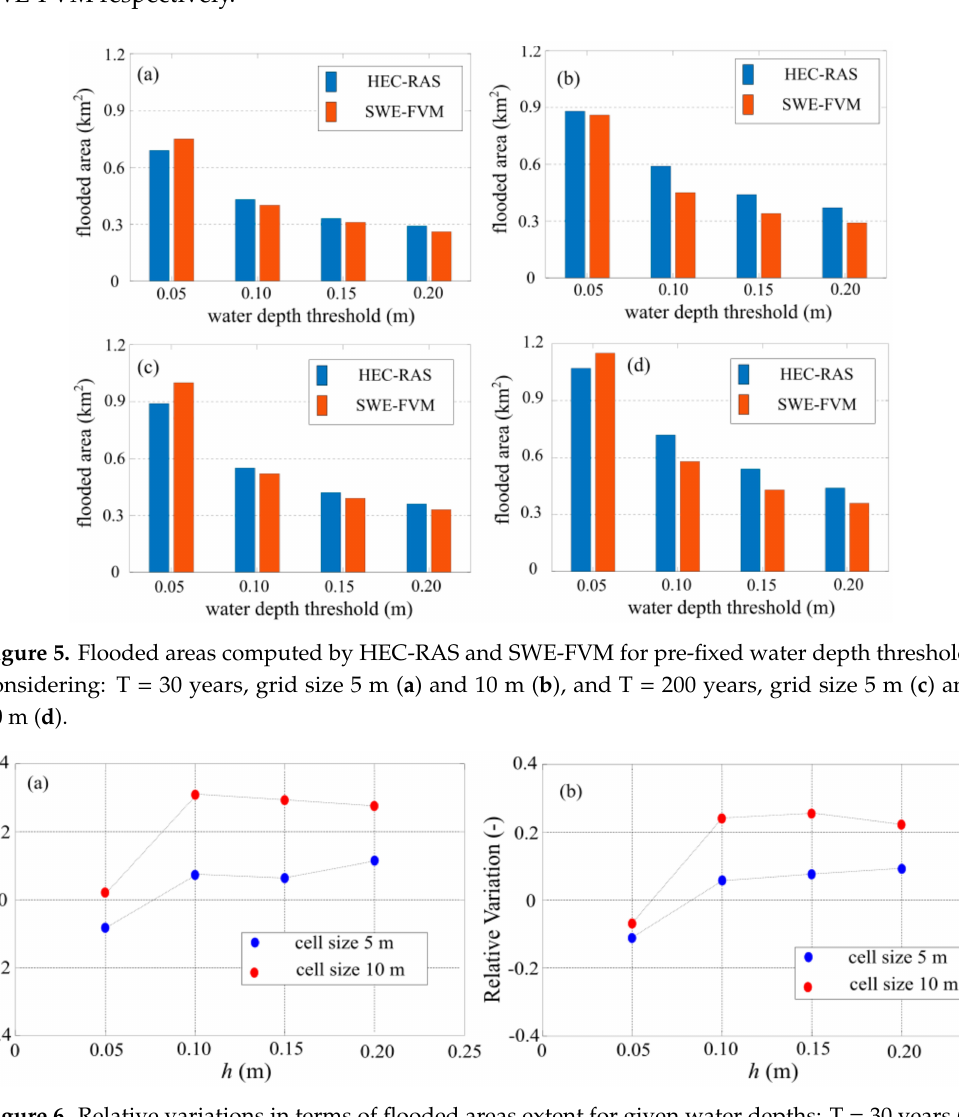
Figure 6. Relative variations in terms of flooded areas extent for given water depths: T = 30 years ( a ) and T = 200 years ( b